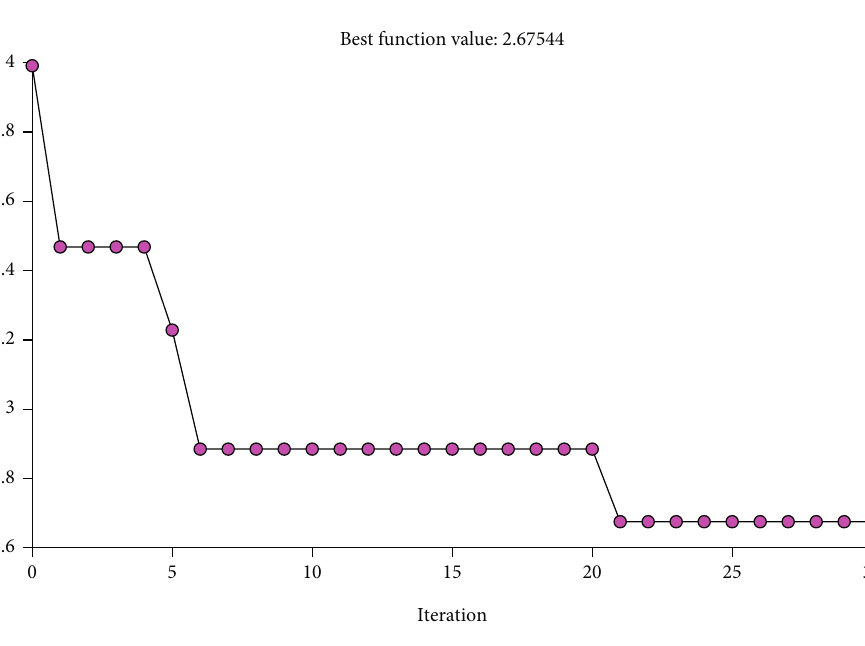
Figure 16: Relative bandwidth optimization iterative process.